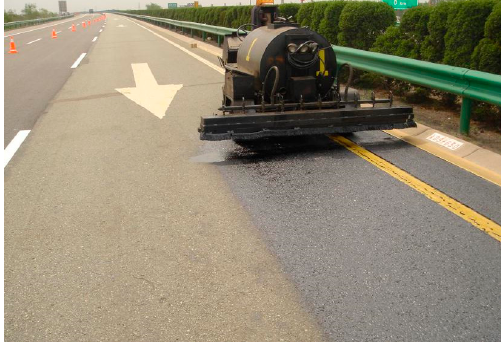
Figure 1. The application of fog seal on pavement.